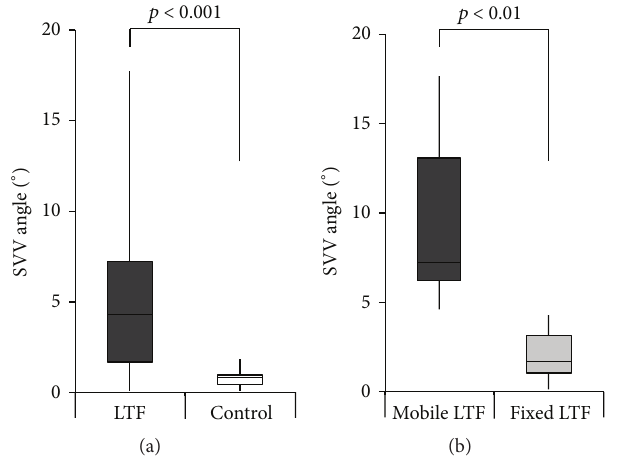
Figure 2: Comparison of SVV angles. (a) Comparison of SVV angles of PD patients with LTF (dark grey) and without LTF (control, white) (4.3 ∘ [range: 0.1–17.7], 𝑛 = 21 , versus 0.8 ∘ [0.1–1.9], 𝑛 = 9 ). (b) Comparison of SVV angles of all PD patients with mobile LTF (dark grey) and all PD patients with fixed LTF (light grey) (7.3 ∘ [4.6–17.7], 𝑛 = 10 , versus 1.7 ∘ [0.1–4.3], 𝑛 = 11